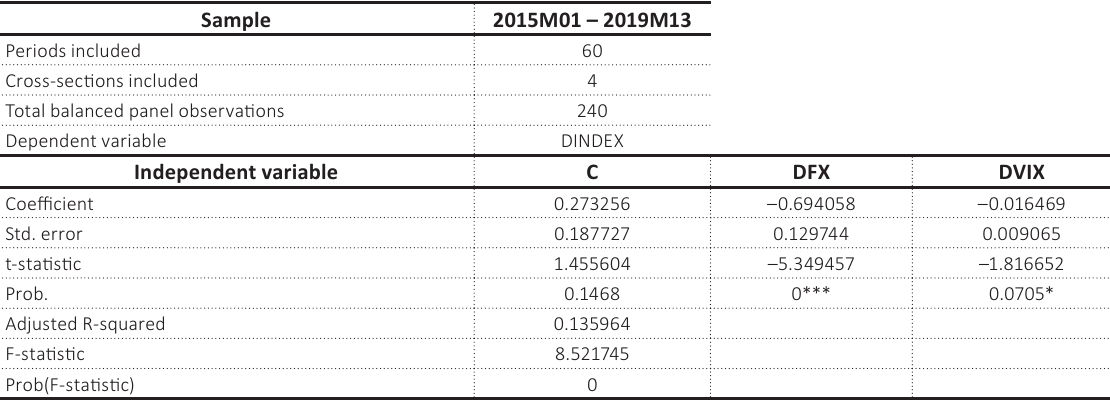
Table 2. Cross-section random effects test equation for Model